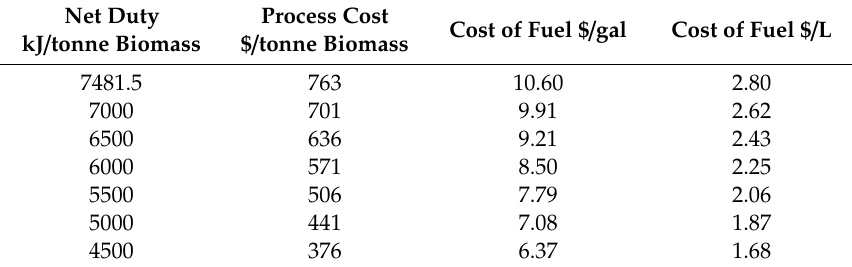
Table 7. Fermentation breakeven analysis for one tonne biomass feed.